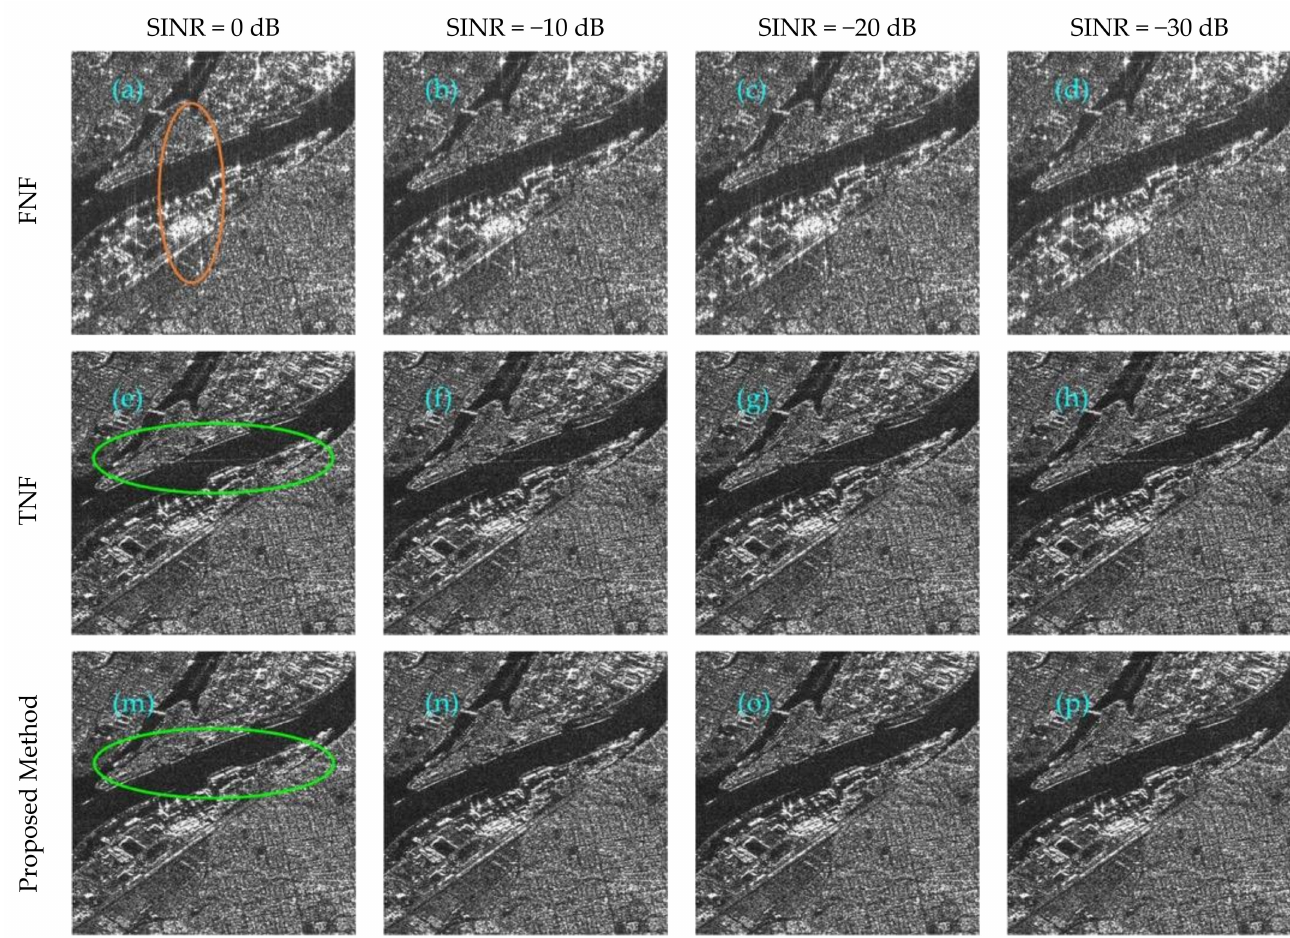
Figure 7. ROIs in Figure 6. ( a – d ) Mitigation results for the FNF method. ( e – h ) Mitigation results for the TNF method. ( m – p ) Mitigation results for the proposed